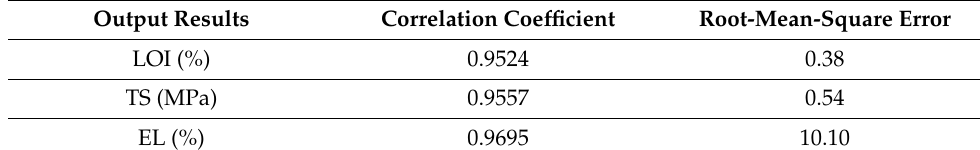
Table 6. The statistical results of the ANN model for the samples in the test set [102].